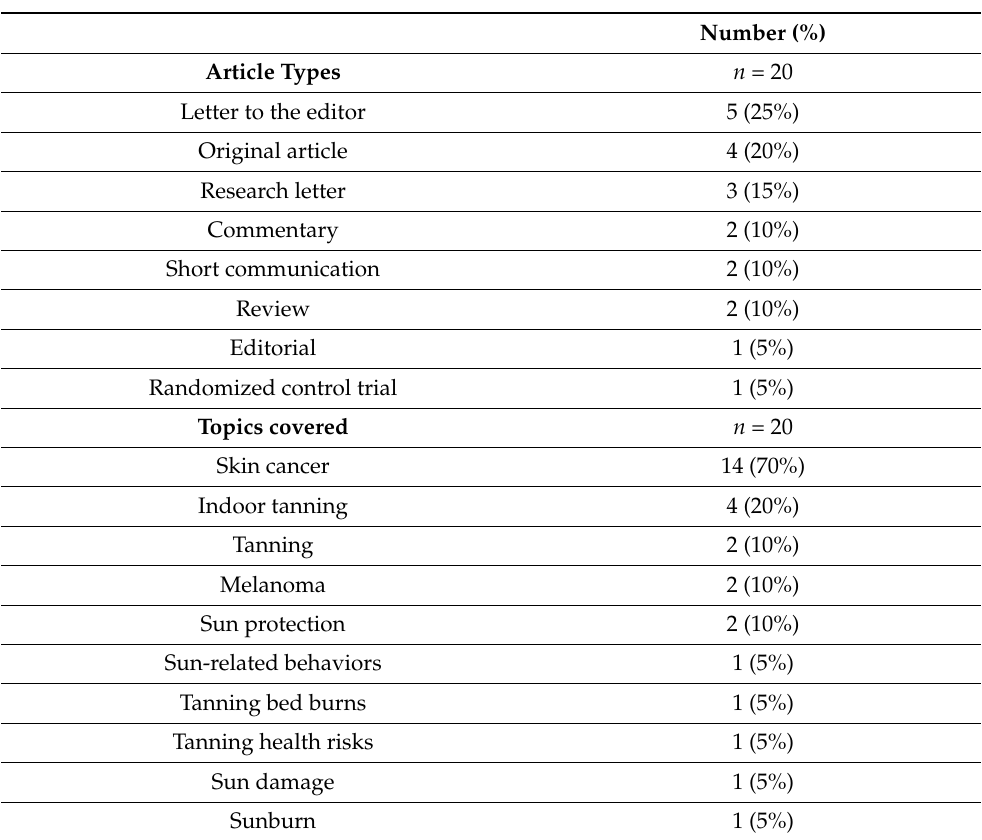
Table 2. Important